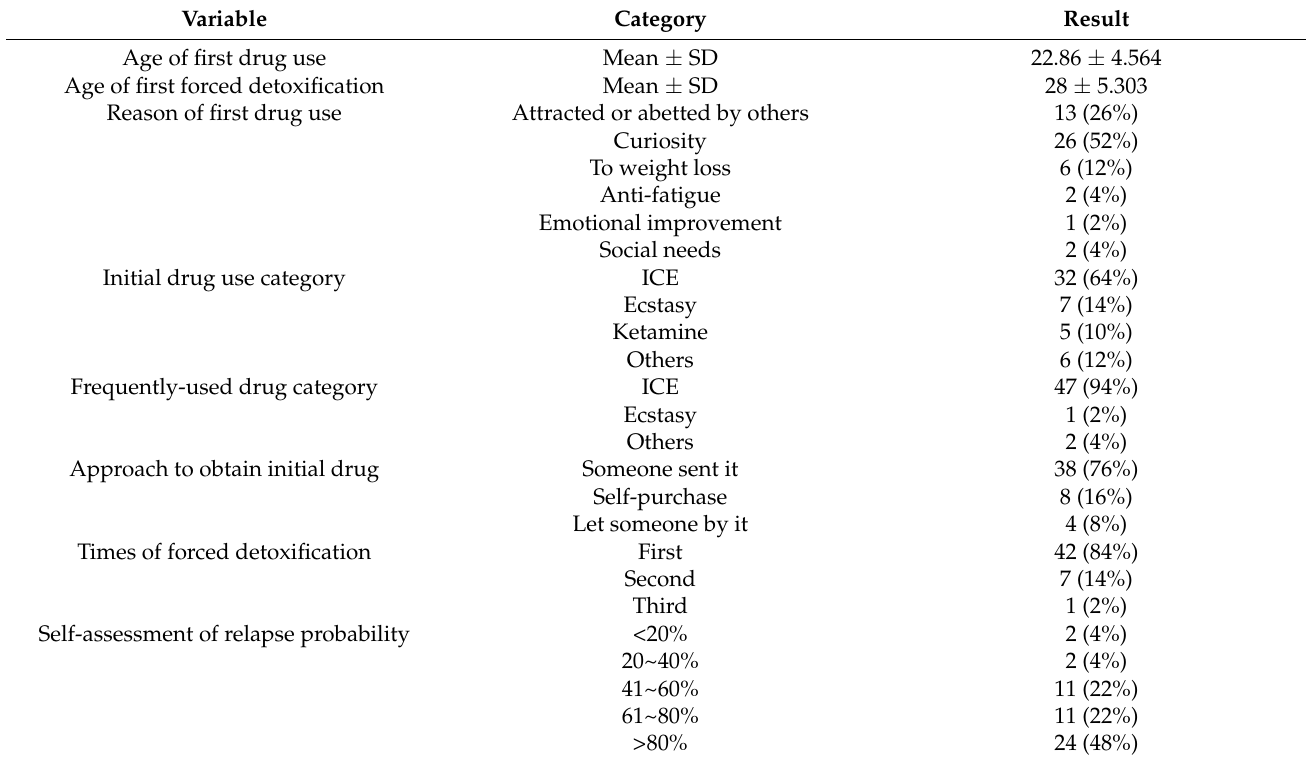
Table 3. Drug use characteristics of abstainers.